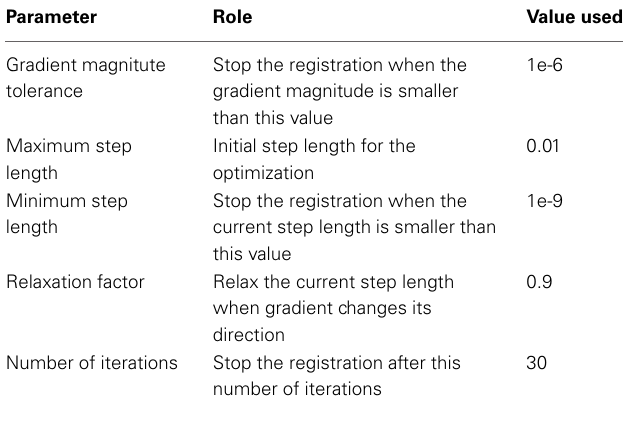
Table 2 | Parameters in rotational